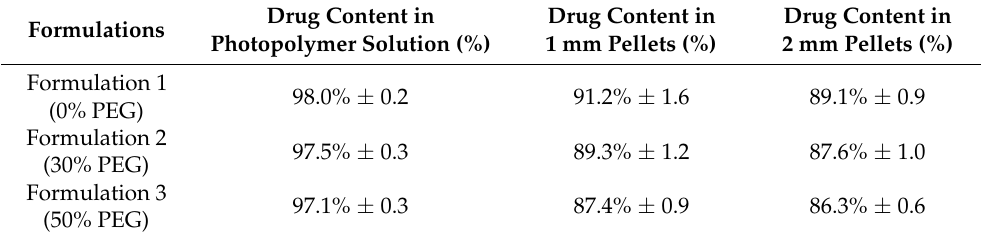
Table 3. Drug content in photopolymer solution and printed mini pellets. Drug Content Formulations